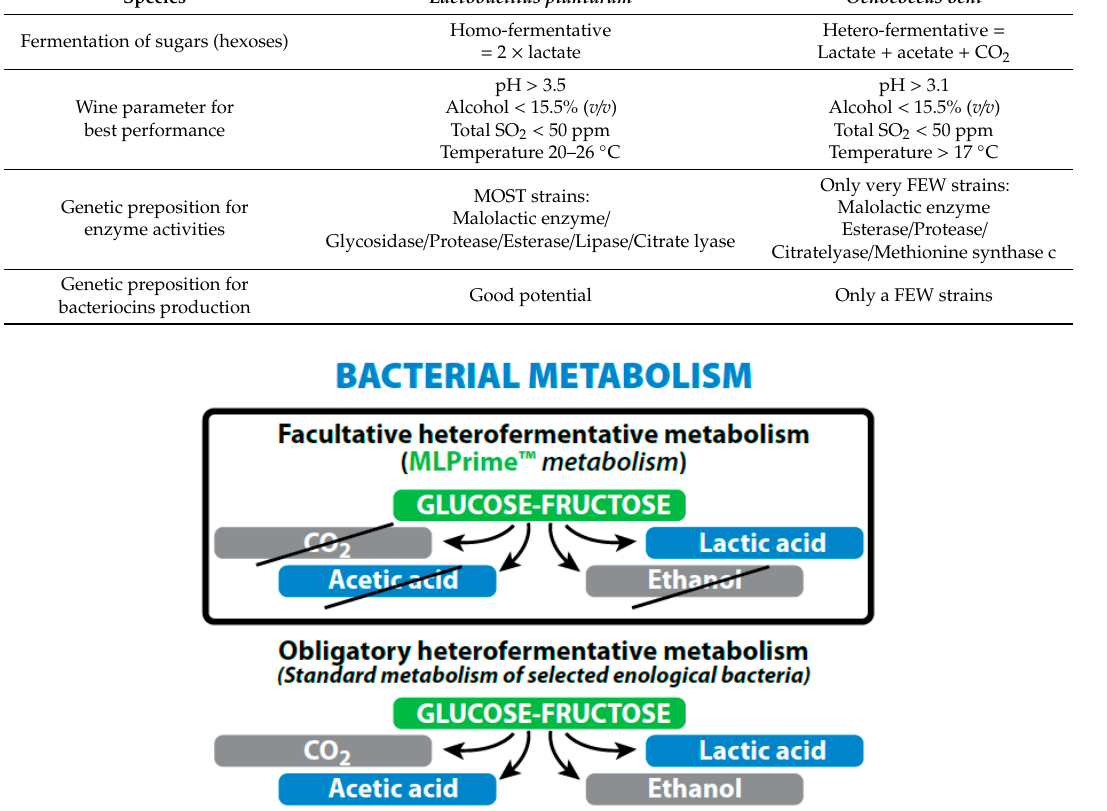
Figure 3. Sugar metabolism of wine lactic acid bacteria.